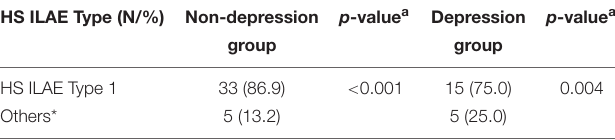
TABLE 6 | Histopathological classification of the patients evaluated in this study, according to the International League Against Epilepsy (ILAE) criteria for the definition of the hippocampal sclerosis type – the comparison between type 1 versus